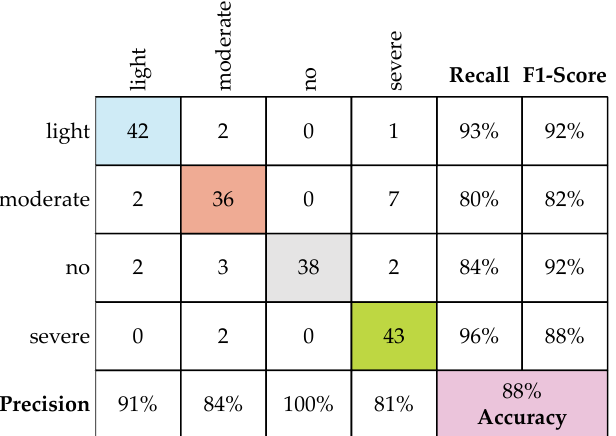
Figure 9. Bar charts showing testing accuracies for datasets A, B, and C using fine-tuned MobileNet CNN model.